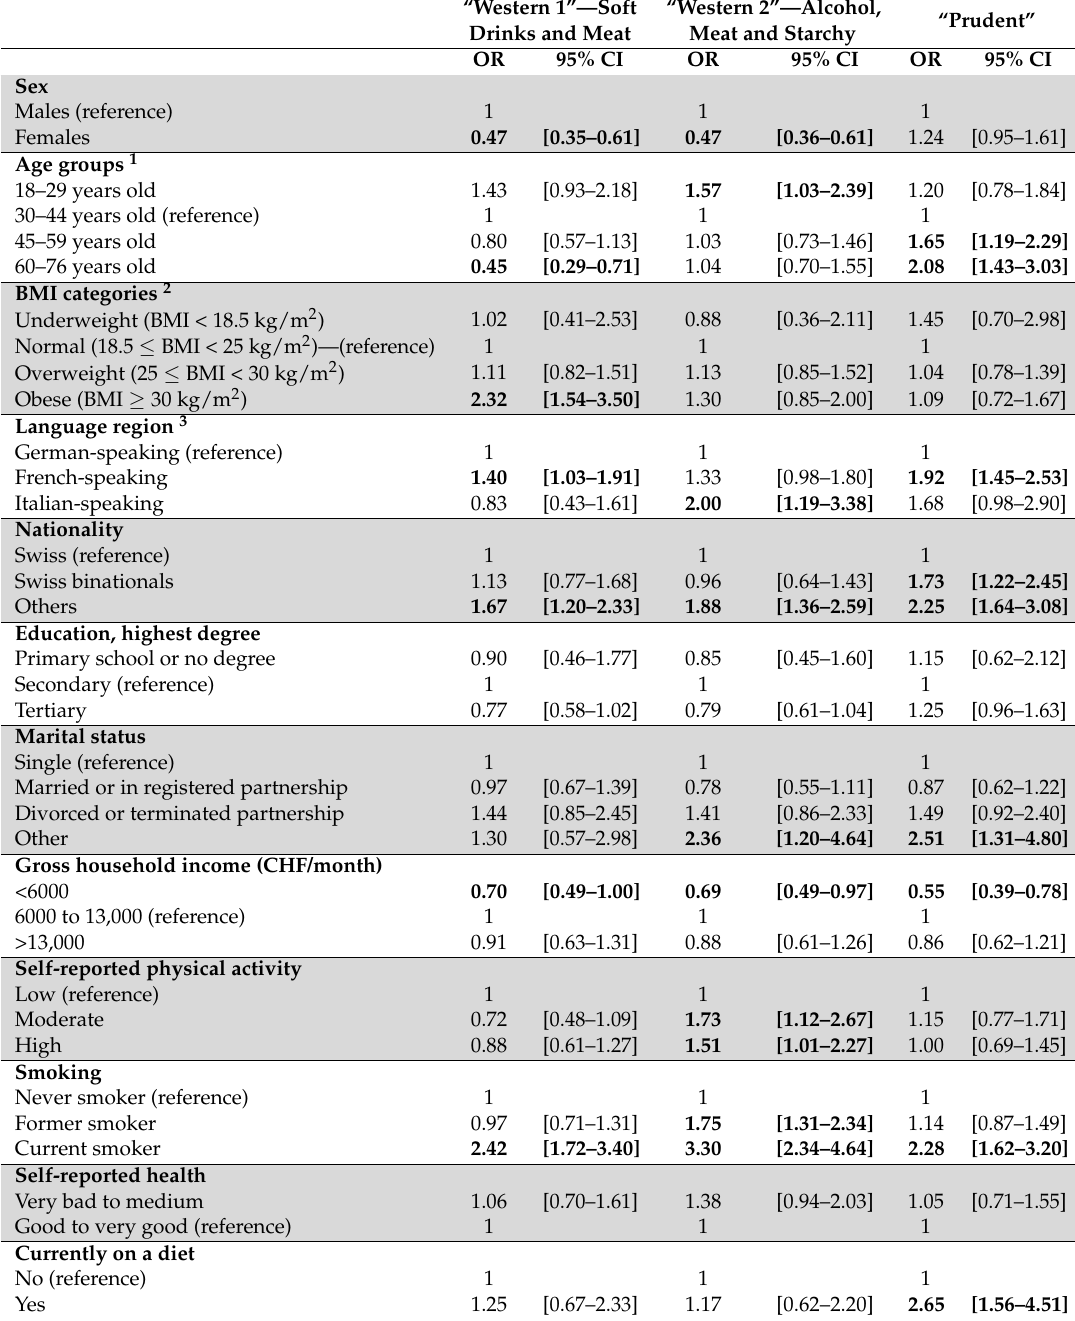
Table 2. Association between dietary patterns and sociodemographic and lifestyle